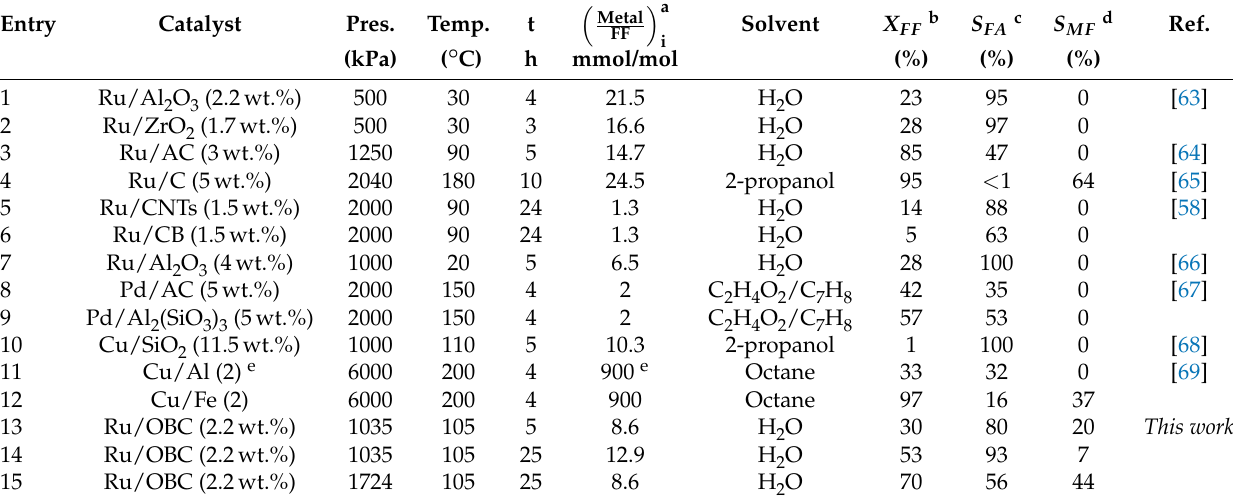
Table 7. Comparison of Catalyst Performance with Literature